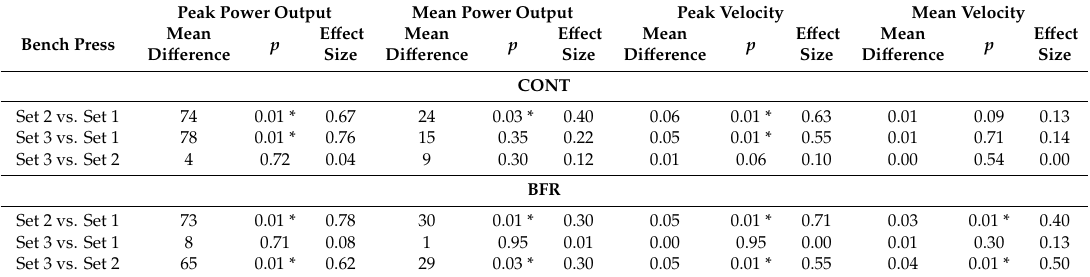
Table 3. A comparison between particular sets of the bench press exercise based on t-test